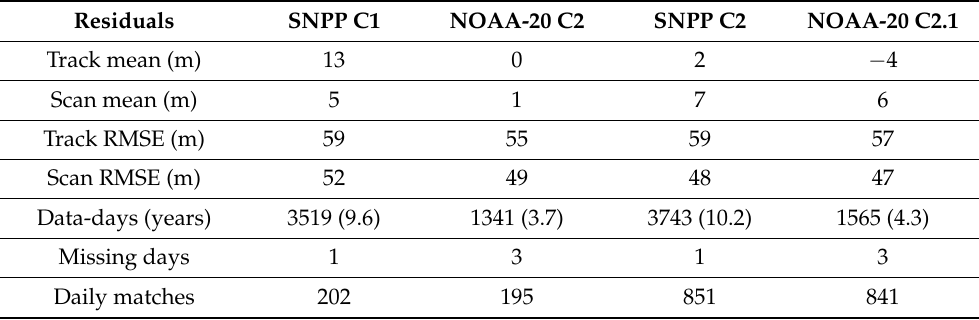
Table 3. Overall SNPP and NOAA-20 VIIRS geolocation accuracy in nadir equivalent